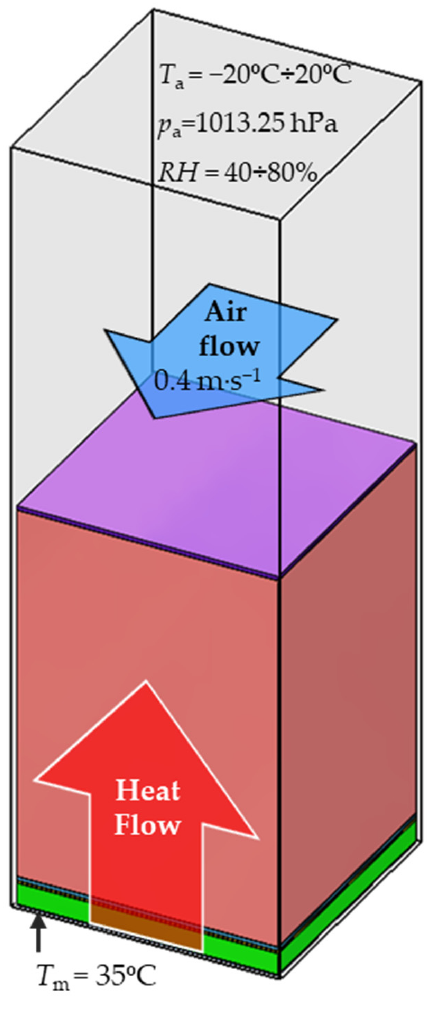
Figure 6. Conditions of the heat transfer simulations.